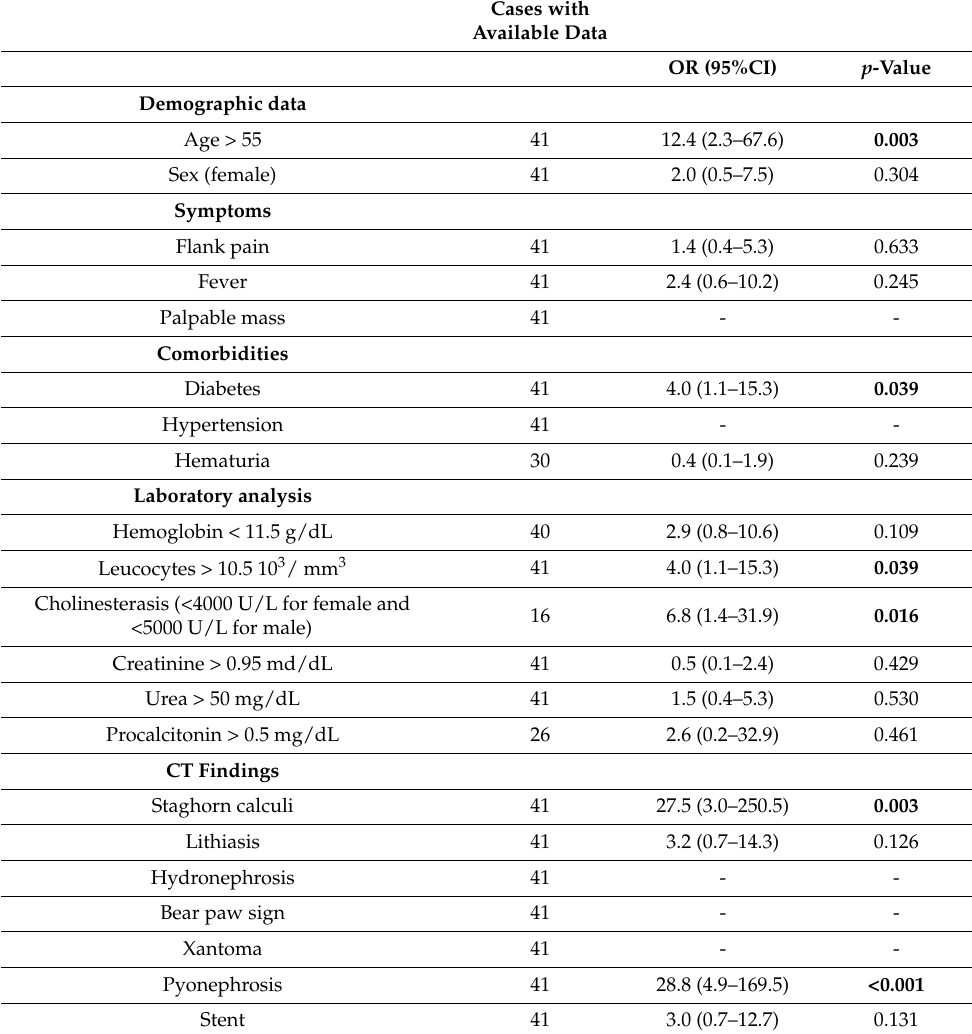
Table 2. Univariable analysis of XGP.